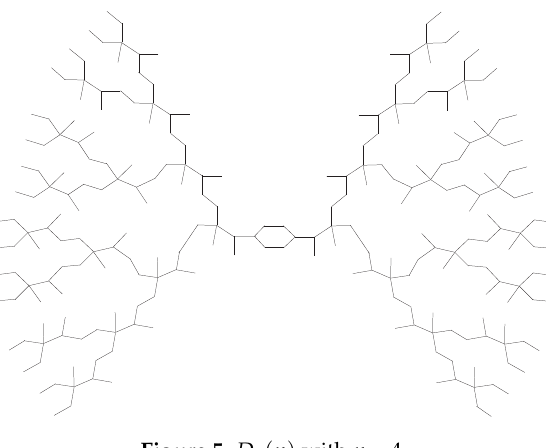
Figure 5. D 5 ( n ) with n =